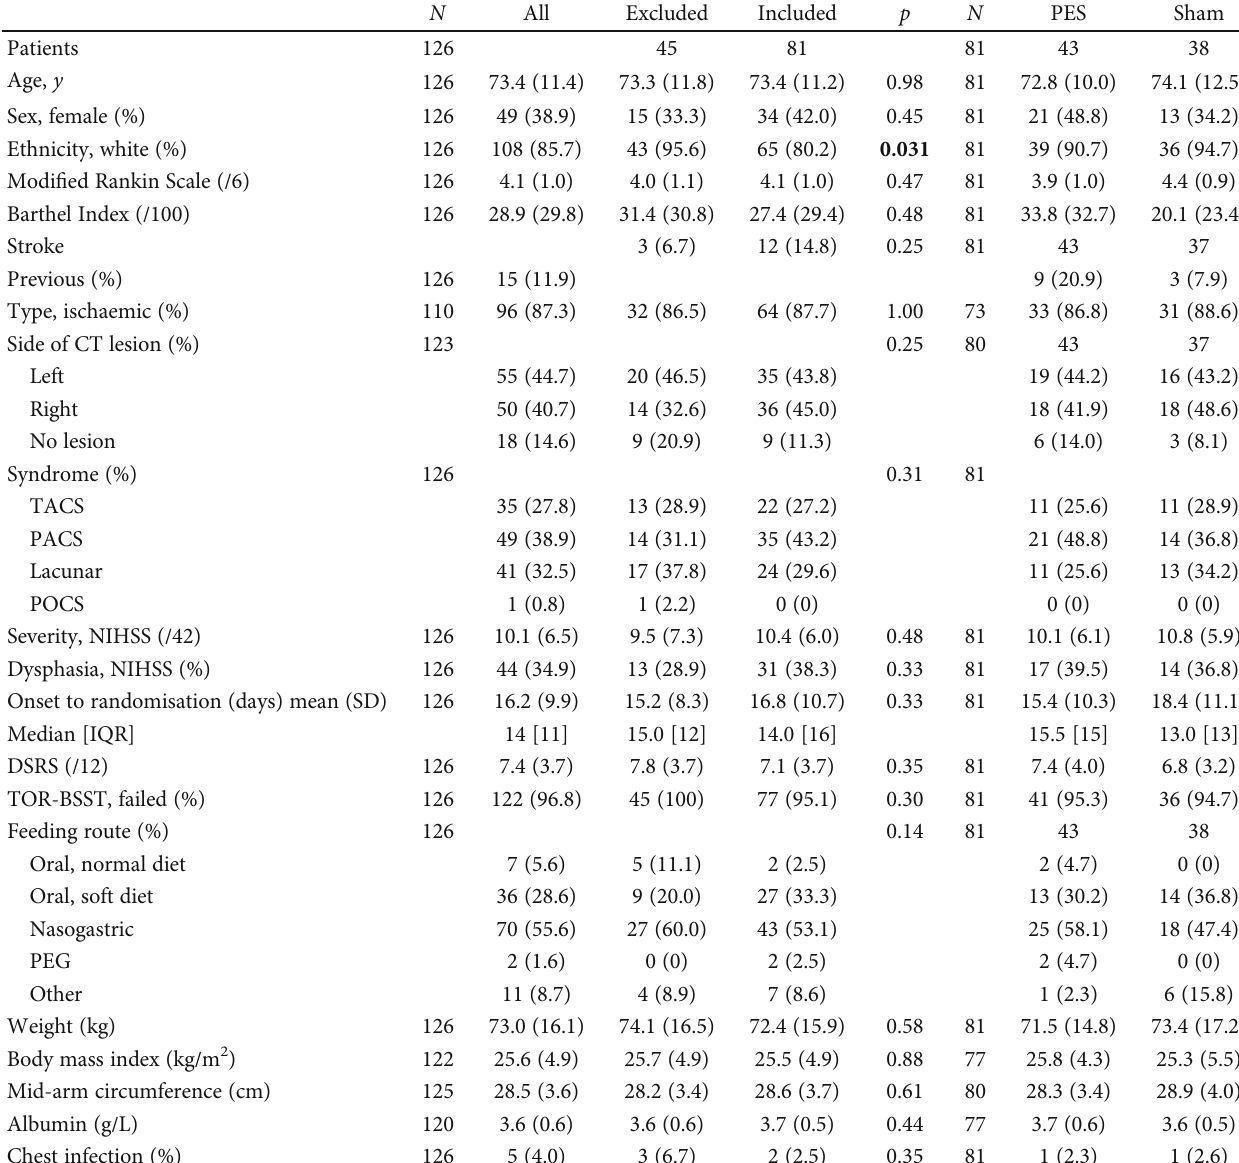
Table 1: Baseline characteristics for participants in STEPS: excluded vs. included ( N = 126 ); included ( N = 81 , PES vs. sham). Data are number (%), median [interquartile range], or mean (standard deviation). Comparison by Chi-Square (Exact) Test/Fisher ’ s Exact Test (binary/ordinal variables) or Welch ’ s T -Test (continuous